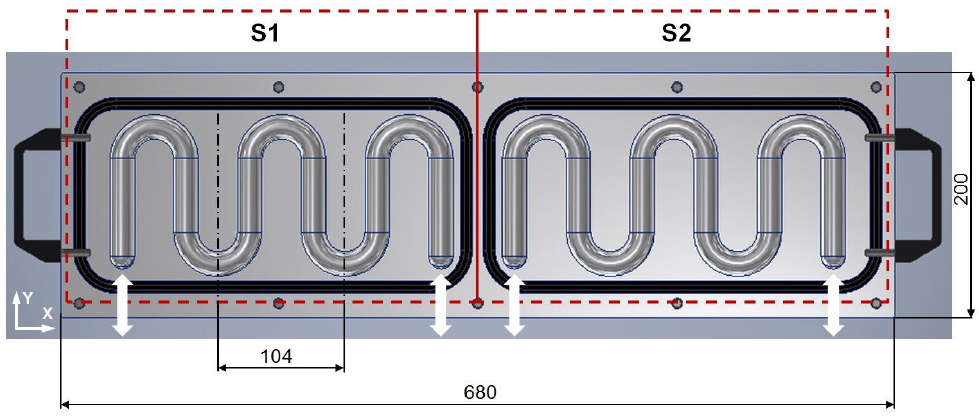
Figure 4. Dimensions of a two-section plate with fluid circulation channels (S1, S2— exchanger sections).